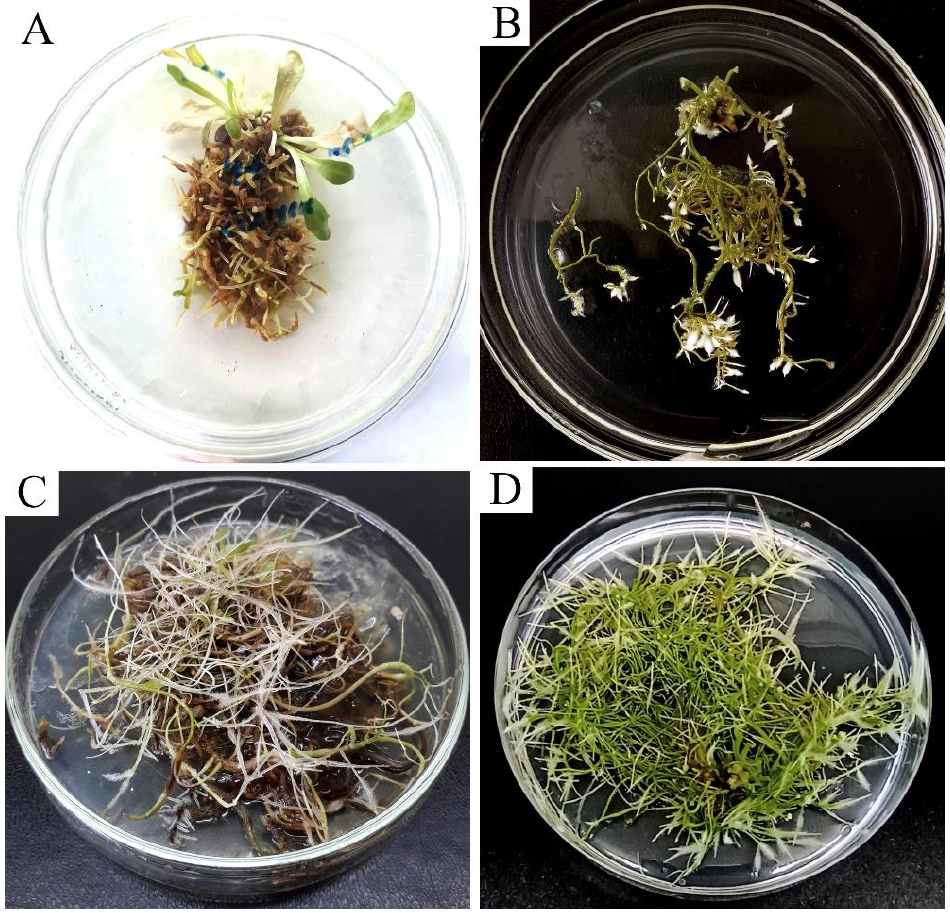
Figure 4. TKS hairy root cultures (our studies). Spontaneous regeneration of shoots was often ob- served in hairy roots ( A , D ). Green hairy roots often developed ( B , D ). With long cultivation, the roots of some lines turned brown and died ( C ).